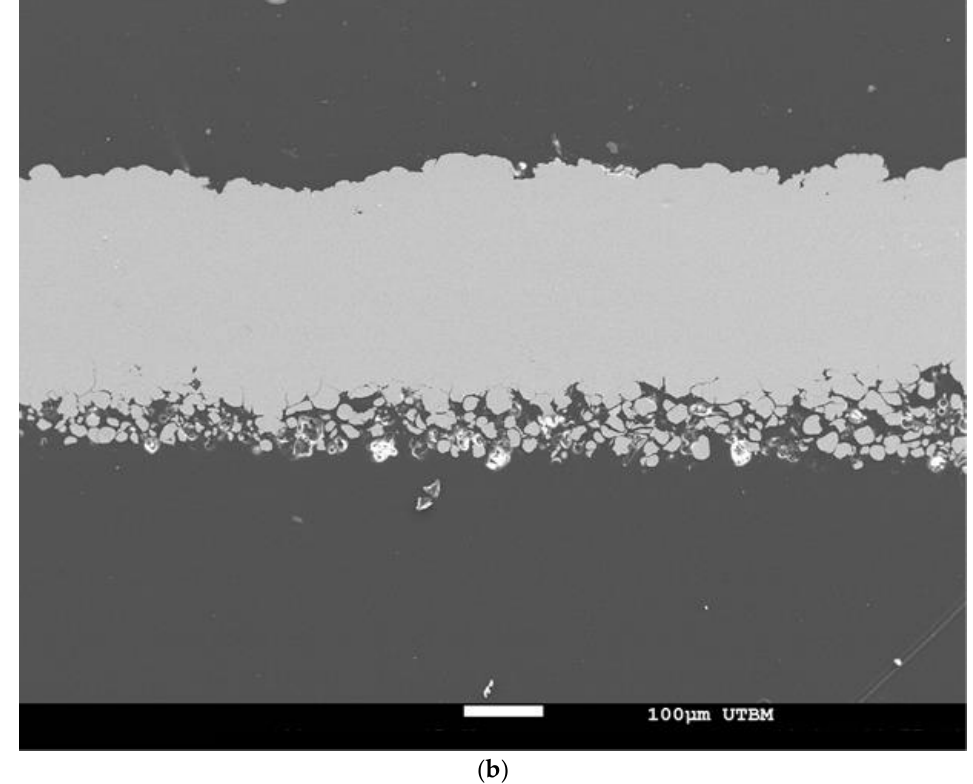
Figure 5. Typical coating cross section for the deposition set V7 ( a ) and V8 ( b ).